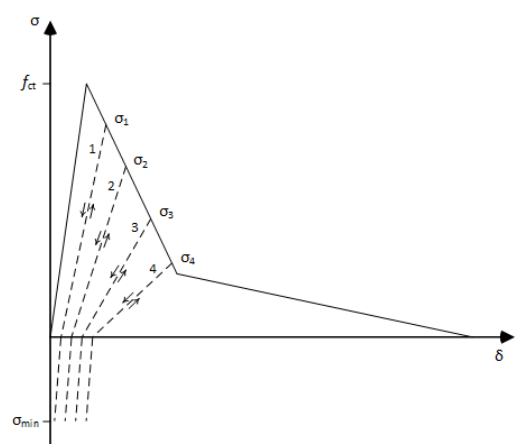
Figure 6. Schematic representation of the cyclic loading